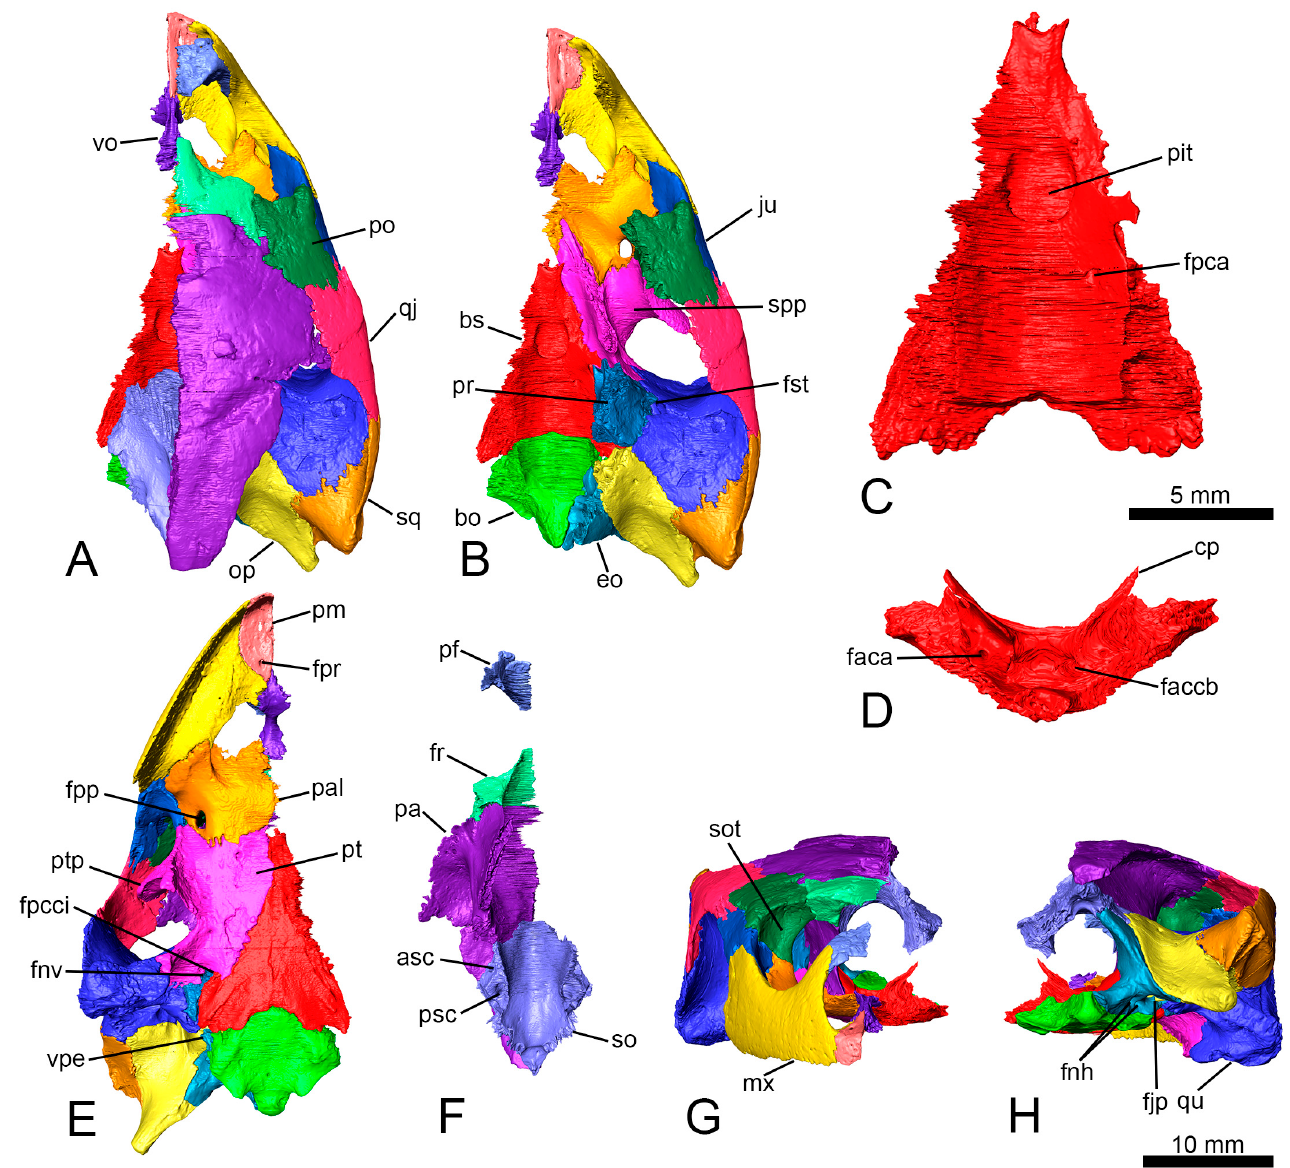
Figure 2. FR 4922, three-dimensional reconstruction of the skull of the holotype of Euraxemys essweini (Euraxemydidae) from the Albian of Araripe Basin in Brazil showing the right bones and medial odd bones virtually removing the sediment in dorsal ( A , B ), ventral ( E , F ), anterior ( G ), and posterior ( H ) views. Each bone is shown with a different color. The prefrontal, the frontal, the parietal, and the supraoccipital have been virtually removed ( B ) to show the dorsal palatal and braincase bones. The cranial roof bones are shown in ventral view ( F ). Basisphenoid ( C , D ) in dorsal ( C ) and anterior ( D ) views.